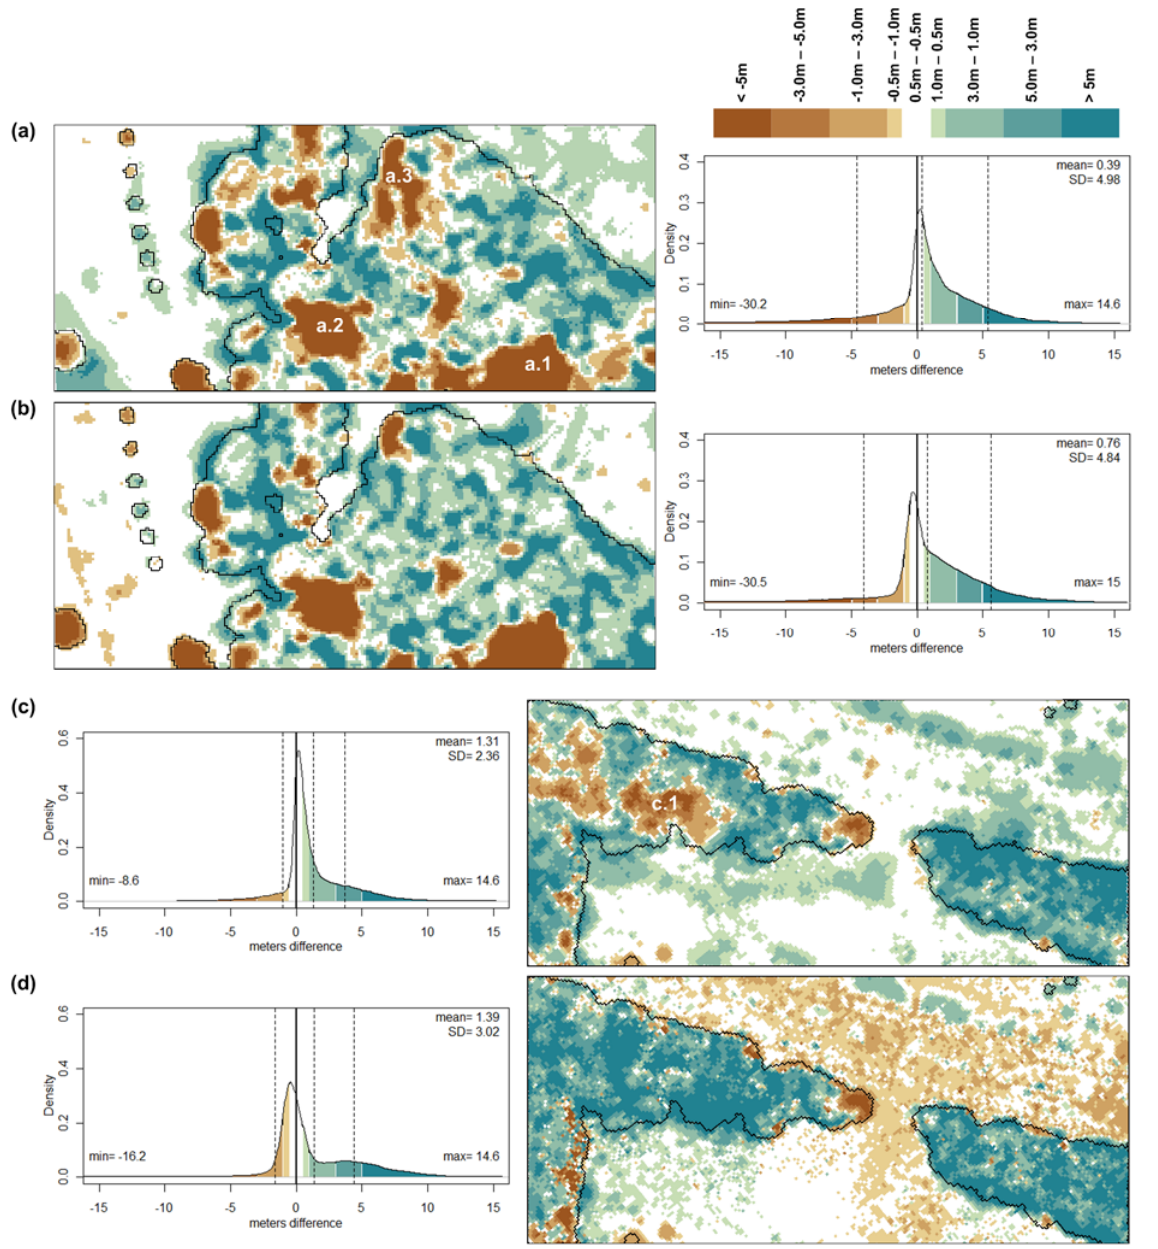
Figure 7. Maps and density plots of differences in Ecosynth CHMs after subtracting LiDAR CHMs, in m. Knoll Ecosynth CHM ( a ) and Ecosynth CHM with LiDAR DTM ( b ). Herbert Run Ecosynth CHM ( c ) and Ecosynth CHM with LiDAR DTM ( d ). Black lines in difference maps delimit tree canopy determined from LiDAR CHM. Colors are same as Figure 5i and 5j. Dashed vertical lines in density plots are mean difference and 1 SD from mean, solid vertical lines at